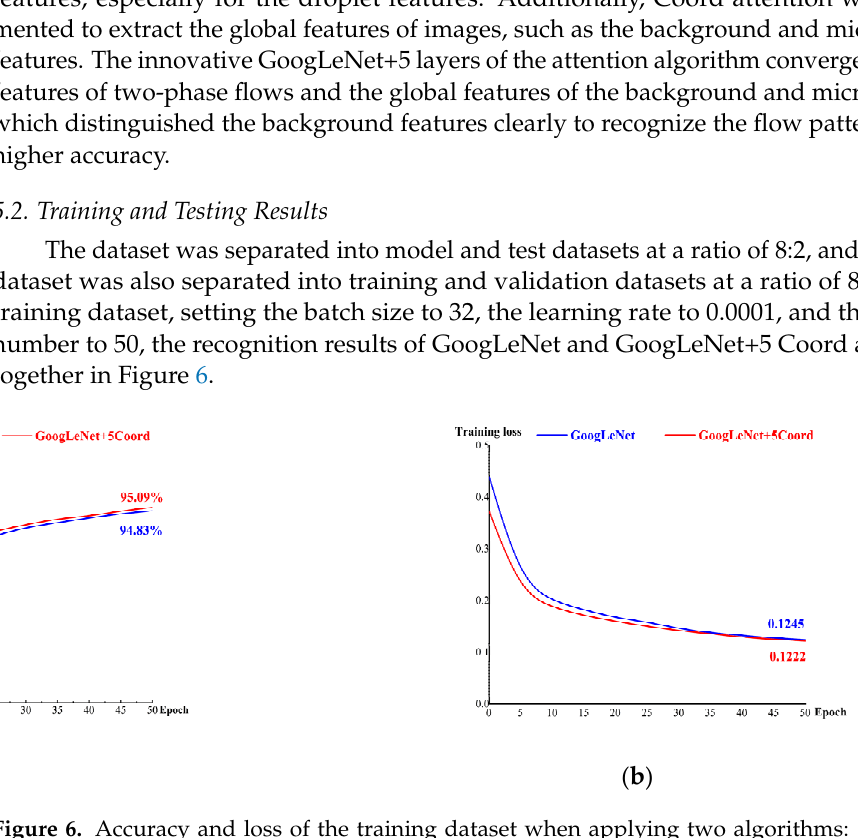
Table 4. The accuracy of the GoogLeNet+5 layers with different attention.